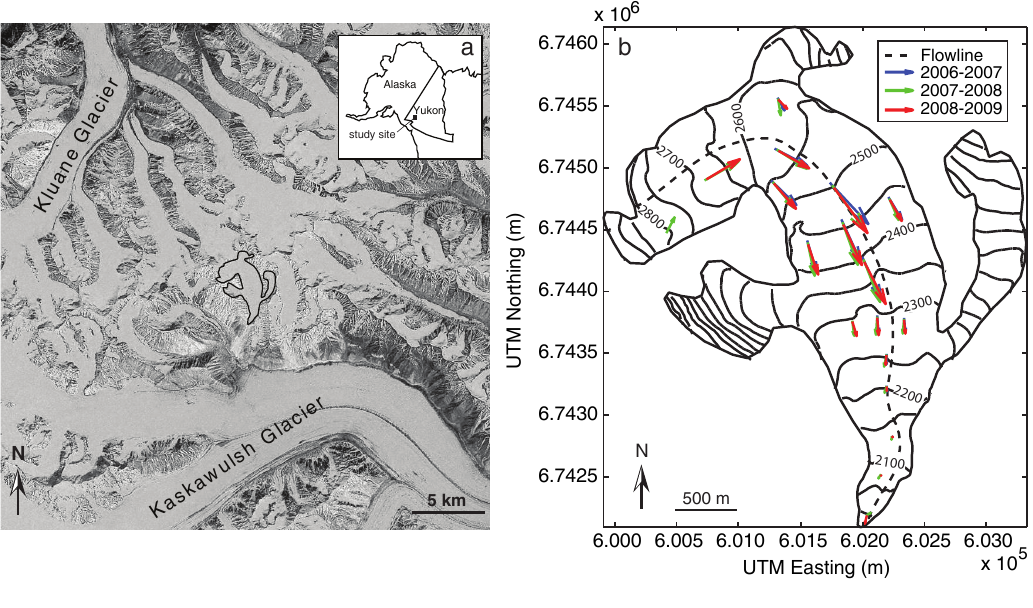
Fig. 1. Study site. (a) Study glacier (outlined) in the Donjek Range, southwest Yukon, Canada. (b) Study glacier with annual velocity vectors at stake locations. Surface contours in